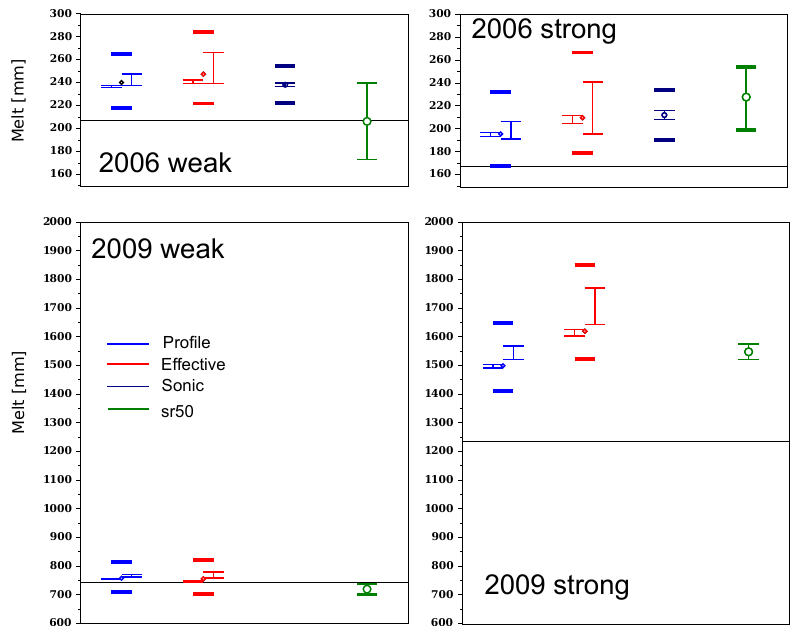
Figure 9. Cumulated melt from the SR50 and the SEB calculated with different methods, for WF with low TKE and SF with high TKE conditions during the 2006 campaign and WF and SF conditions during the 2009 campaign. (black horizontal line) Radiative balance, (dark green) melt measured by the SR50 and (light blue) net turbulent flux ( H + LE) evaluated with the profile method, (red) with the effective roughness and (dark blue) with the EC method. The maximum and minimum melt values obtained with the Monte Carlo approach are shown, with random errors due to the turbulent fluxes uncertainty. The thick horizontal bar shows the maximum and minimum melt values due to the error on net shortwave radiation. The interval for the SR50 error is